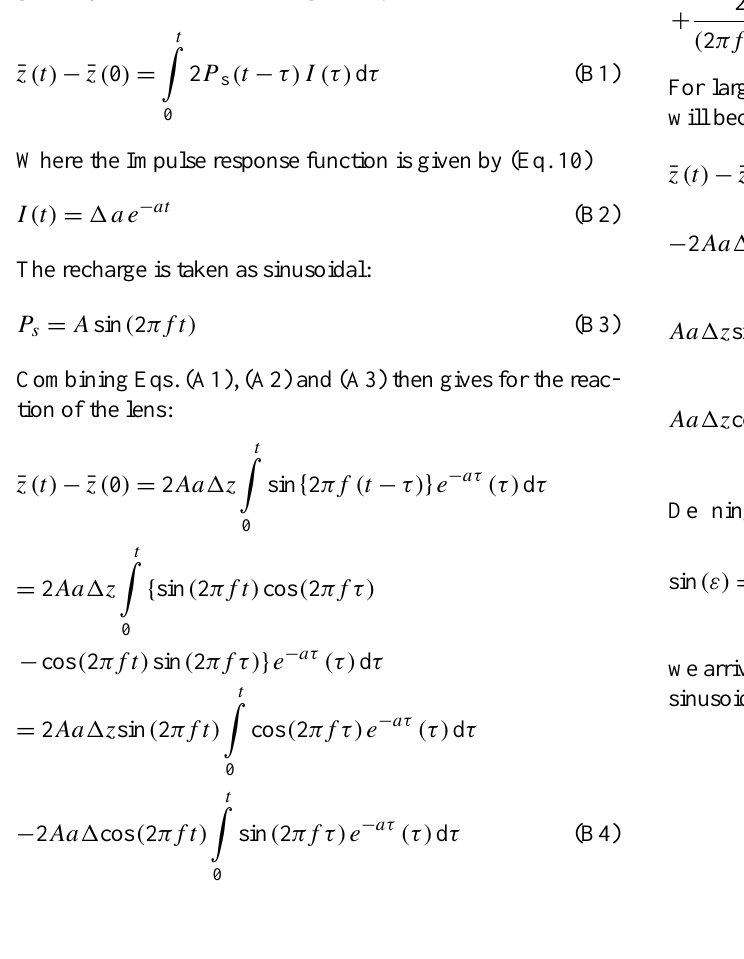
10 − 9 m 2 s − 1 (b) , leading to an effective dispersivity ( α eff ) of